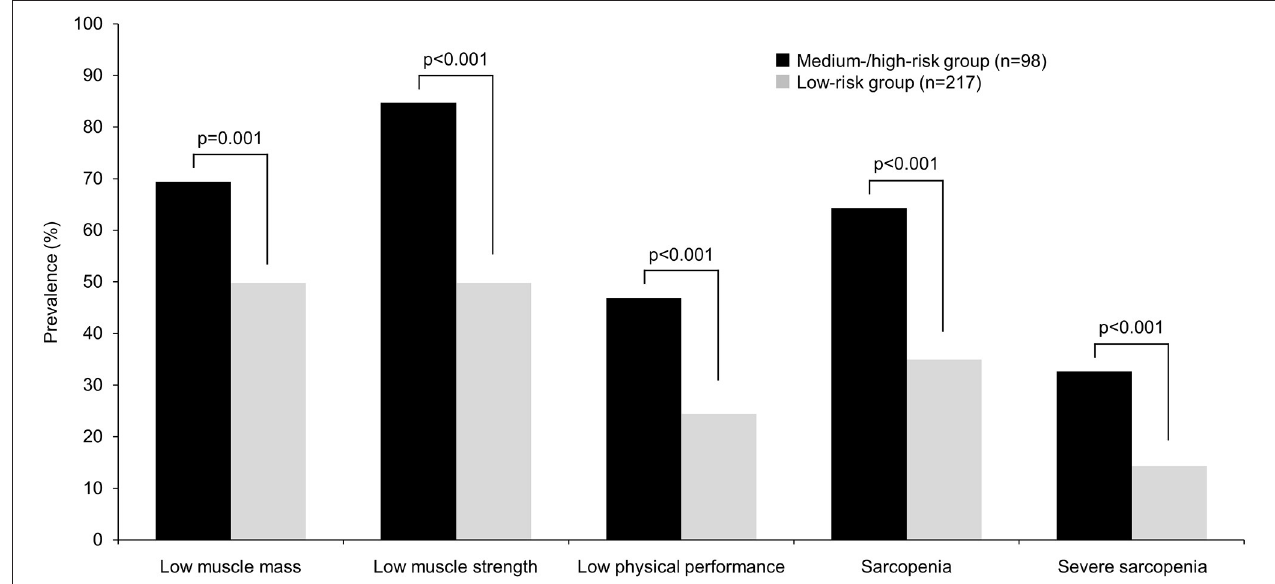
FIGURE 1 | Prevalence of sarcopenia and its components in medium-/high-risk and low-risk groups. Patients were divided into low-risk (score 0–7) and medium-/high-risk (score 8–13) groups based on NRI score. NRI, nutritional risk index.